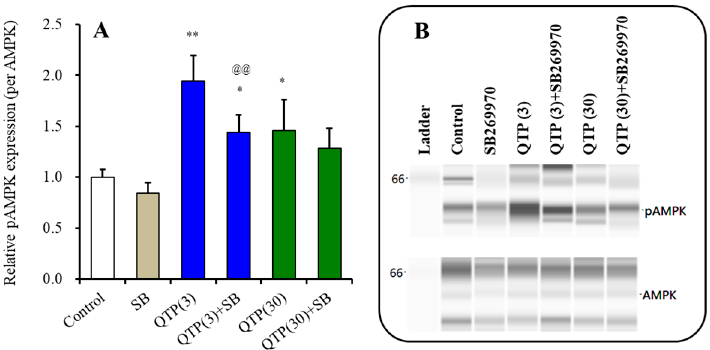
Figure 11. Interaction between chronic exposure (for 14 d) to therapeutic-relevant and supratherapeutic concentrations of quetiapine (QTP) and 10 µM SB269970 (SB) on phosphorylated AMPK (pAMPA) of cultured astrocytes. On the left-side histograms ( A ), ordinate: mean ± SD ( n = 6) of the relative levels of pAMPK. * p < 0.05, ** p < 0.01: relative to control (drug free) and @@ < 0.01: relative to QTP (quetiapine: 3 µM) by one-way ANOVA with Tukey’s post hoc test. Right side panels ( B ) indicate their pseudo-gel images of capillary immunoblo tt ing.